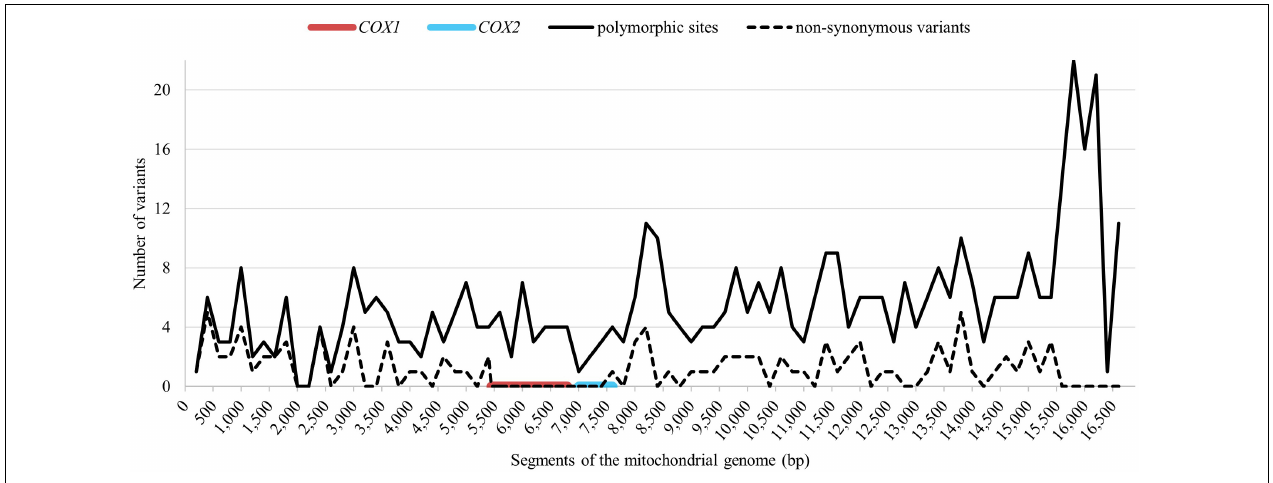
FIGURE 2 | Distribution of the total polymorphic sites (solid line) and the non-synonymous substitutions (dashed line) across the mitochondrial genome. The red line indicates the conserved region around COX1 (EquCab3.0, MT:5,362–6,906) and the blue line indicates the conserved region around COX2 gene (EquCab3.0,